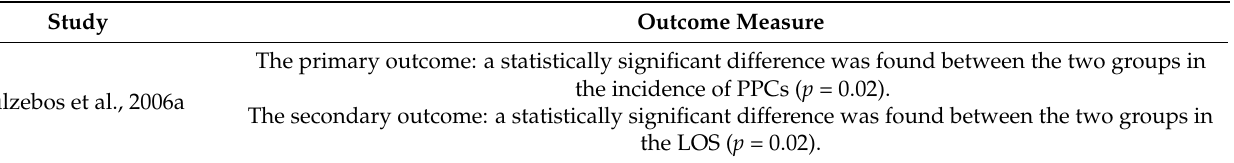
Table 7. The outcomes summary of the included studies.